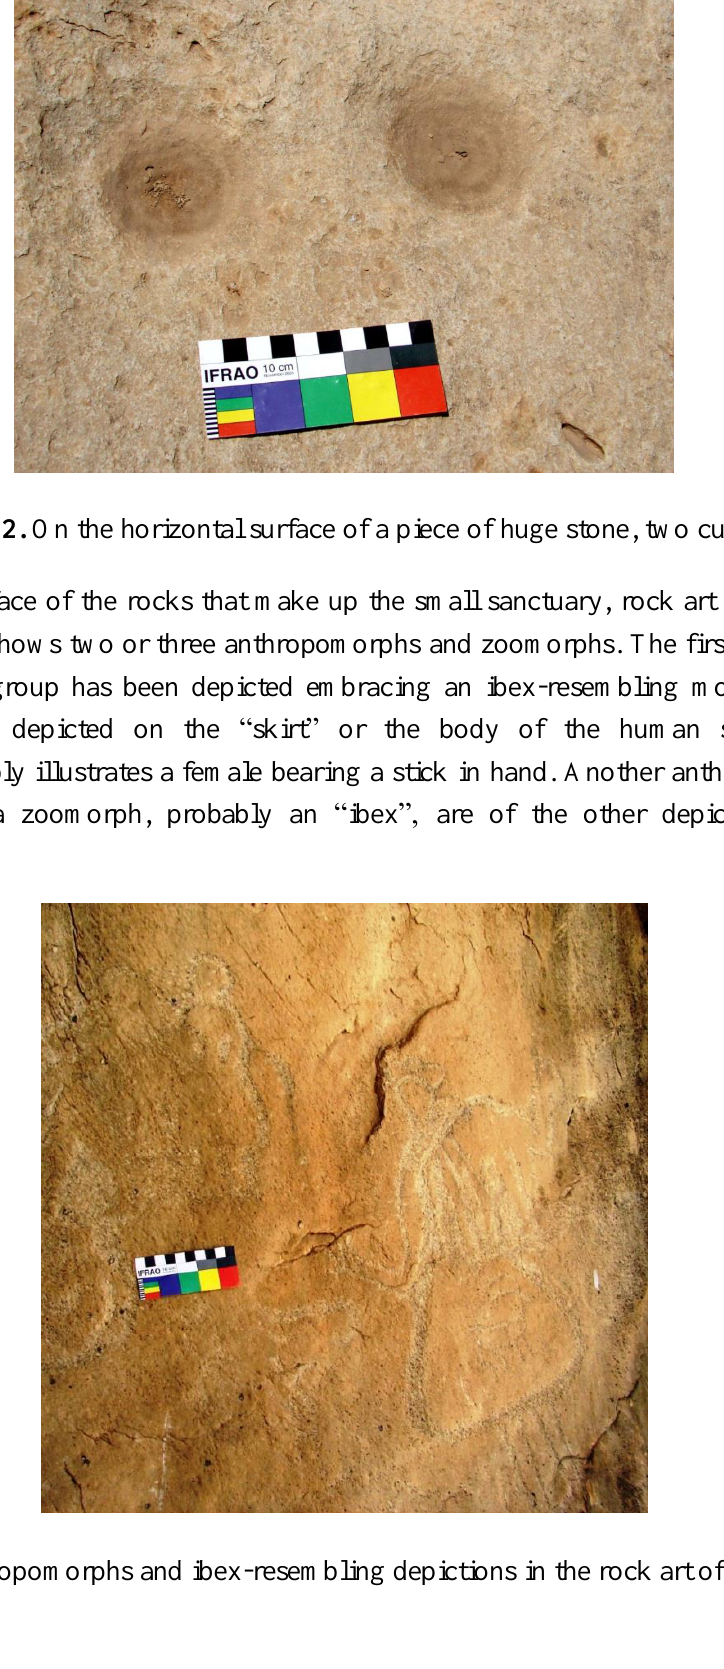
Figure 13. Anthropomorphs and ibex-resembling depictions in the rock art of Ryjab